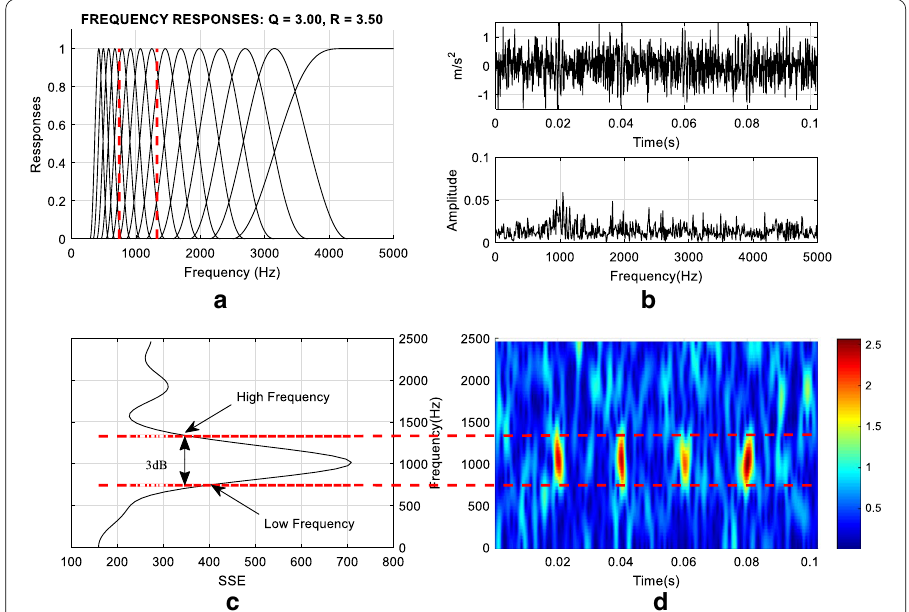
Fig. 2 Schematic diagram of determining the characteristic frequency band by 3 dB bandwidth attenuation method: a frequency response of TQWT; b waveform and spectrum of the simulation signal; c SSE curve; d time–frequency distribution